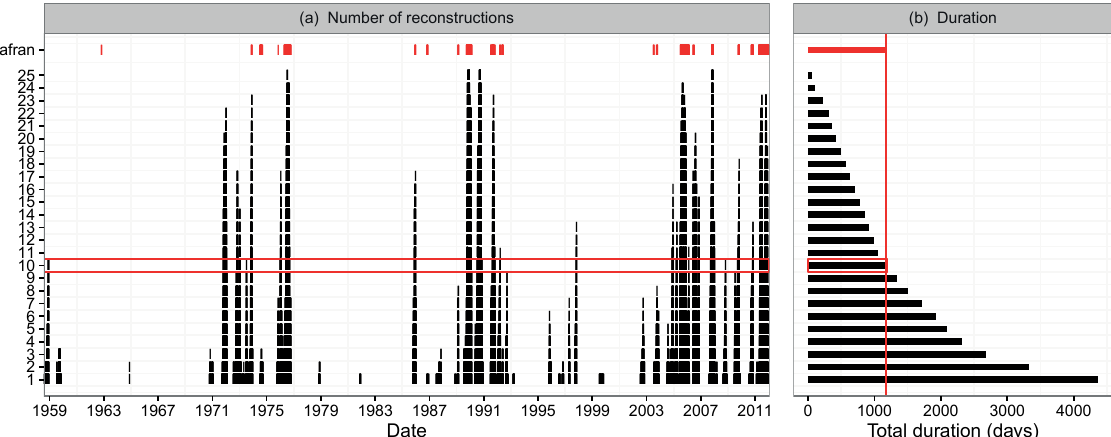
Figure 7. Choice of the minimum number of members for creating the average event series for Station 1 in HER 11. (a) Events from Safran Hydro and average series created with a threshold between 1 and 25 members. (b) Computation of the number of days simulating an extreme low-flow event for Safran Hydro and the 25 series of average events. The number of members providing the closest average events’ total duration to the Safran Hydro events’ total duration – here 10 – is selected.